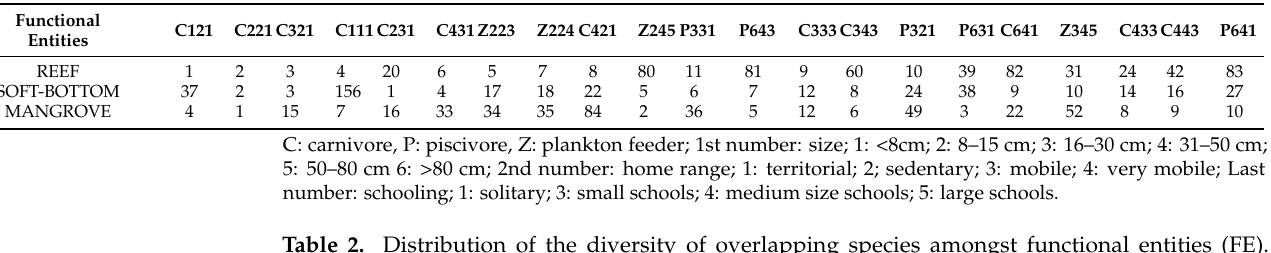
Table 1. Ranks of the 10 most diverse functional groups within each habitat. The functional groups are ordered according to the total number of species they represent. Each functional group is coded as follows.